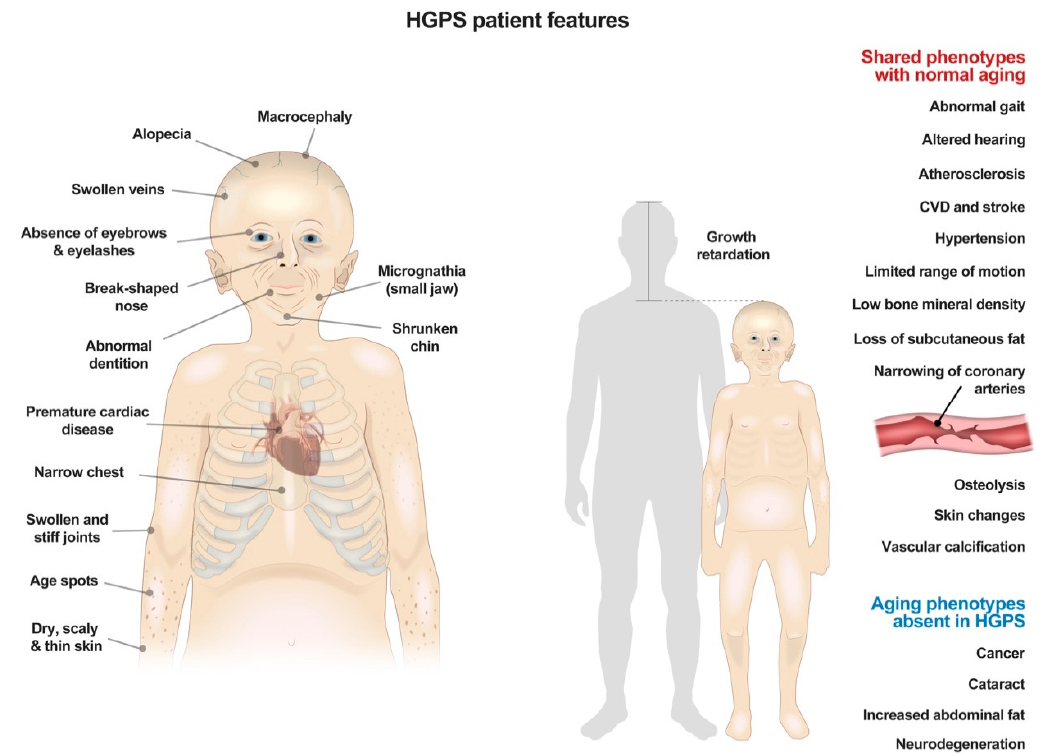
Figure 1. Summary of physical features and clinical symptoms in patients with Hutchinson–Gilford Progeria Syndrome.